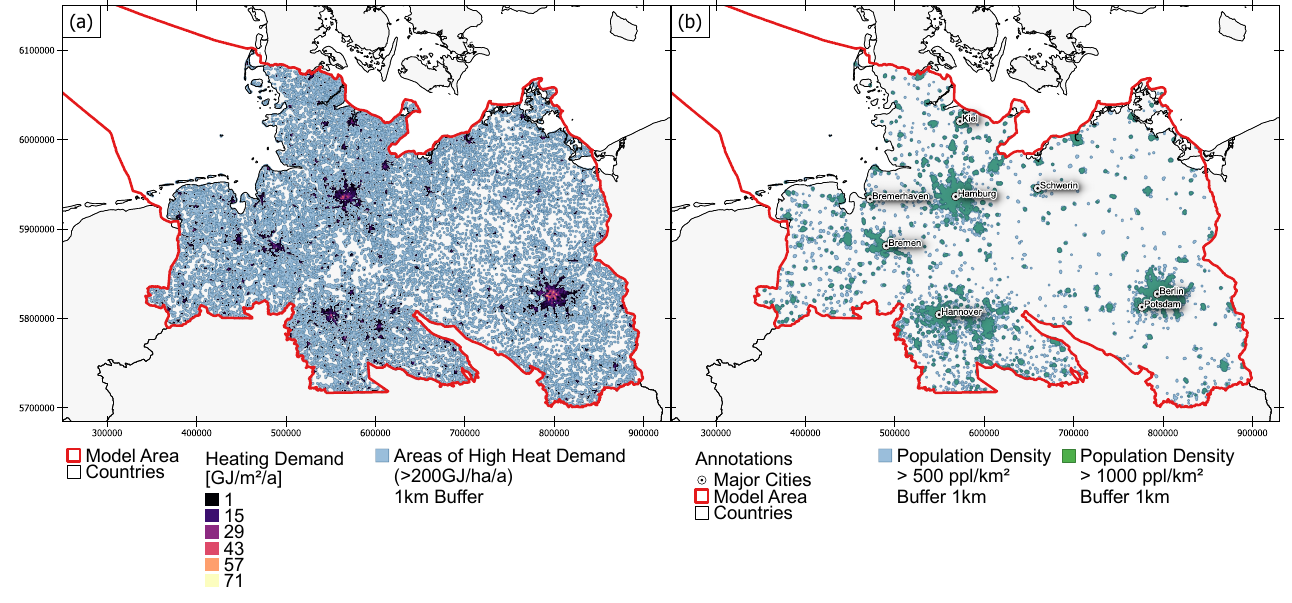
Figure 4. ( a ) Heating demand in the model area. Color-coding indicated below the map; ( b ) Areas of high population density in the model area. Color-coding indicated below the map; ( a , b ) Coordinates are in UTM Zone